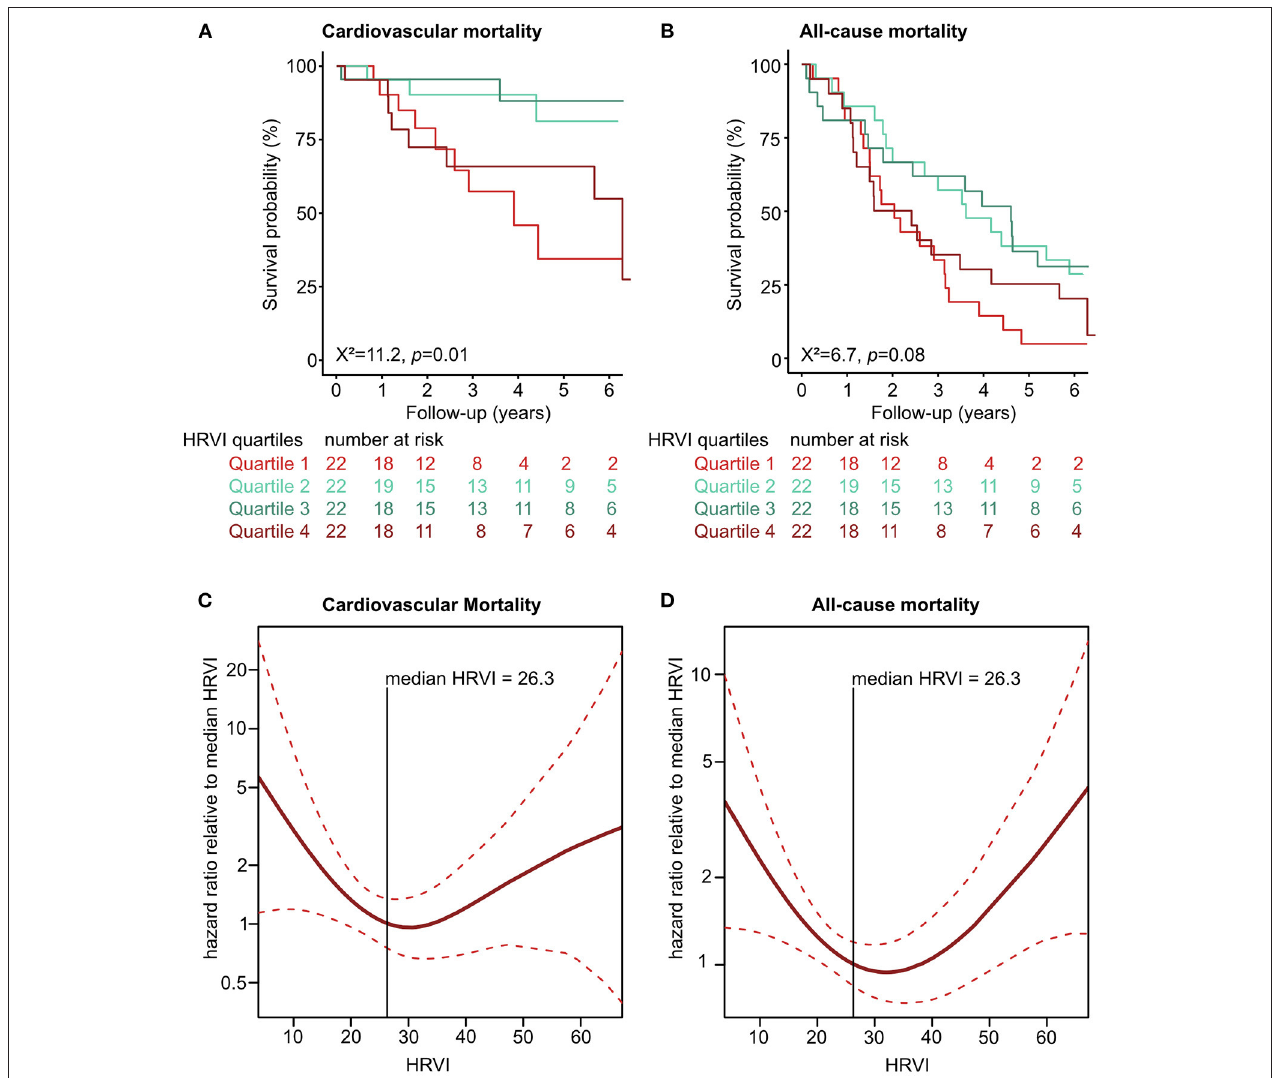
FIGURE 2 | Non-linear association of HRVI with mortality. Univariate association of HRVI with cardiovascular (A) and all-cause mortality (B) in Kaplan-Meier analyses. Non-linear univariate Cox regression analysis using penalized smoothing splines for cardiovascular (C) and all-cause mortality (D) . HRVI, heart rate variability triangular